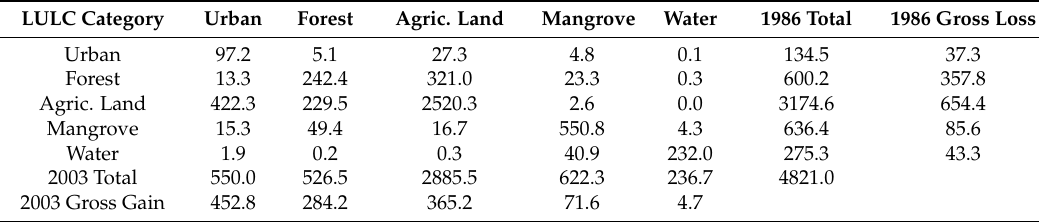
Table 5. Land-cover transition matrix for the Greater Port Harcourt watershed area, 1986 to 2003. LULC Category